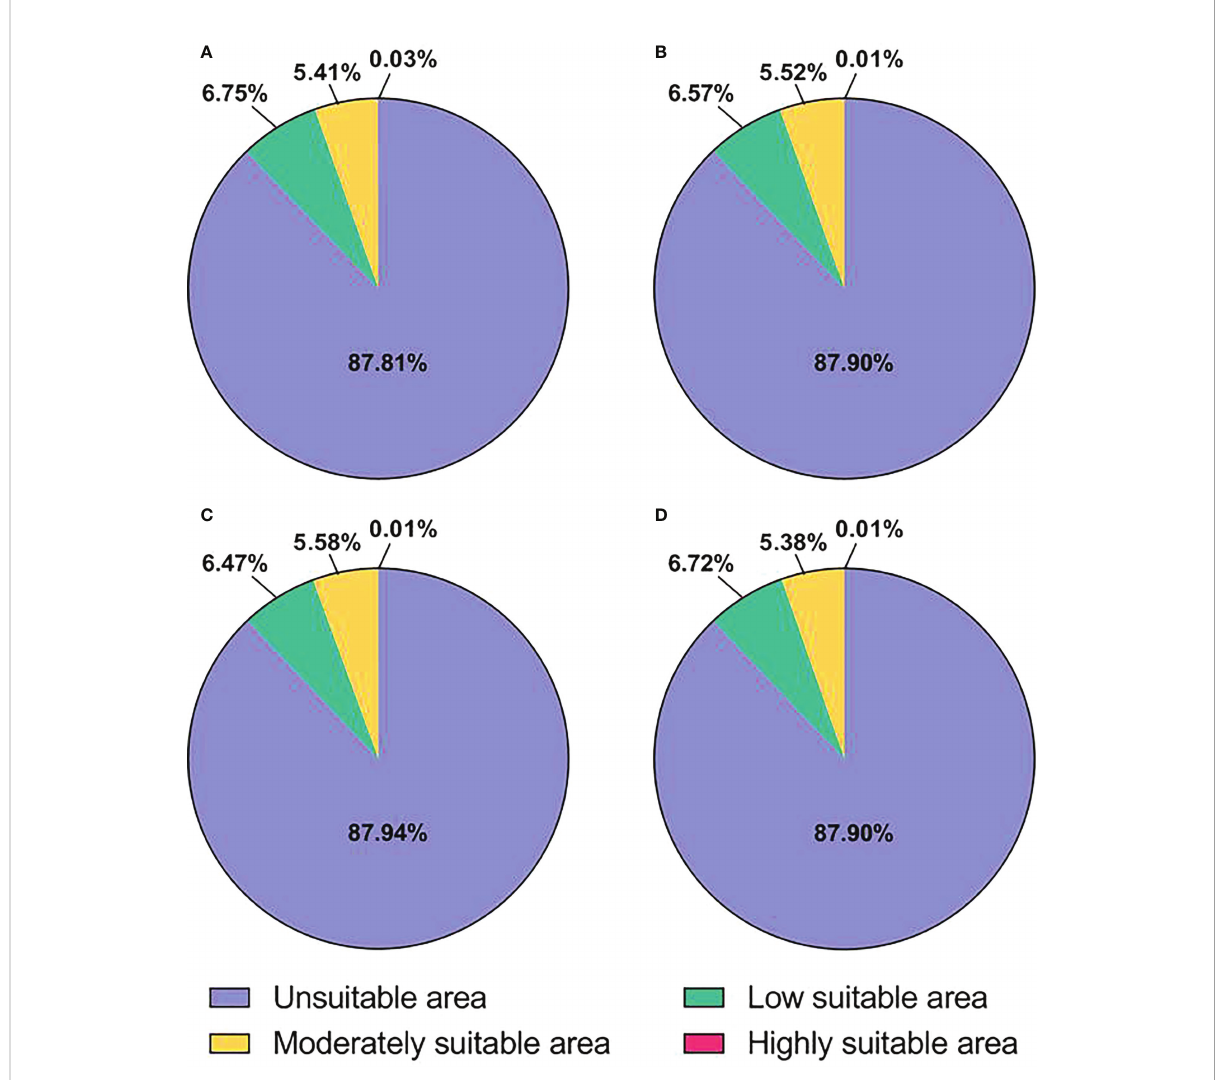
FIGURE 4 Proportion of suitable area for E . corollae . (A) , Current climatic conditions. (B) , RCP2.6 climatic conditions. (C) , RCP4.5 climatic conditions. (D) , RCP8.5 climatic